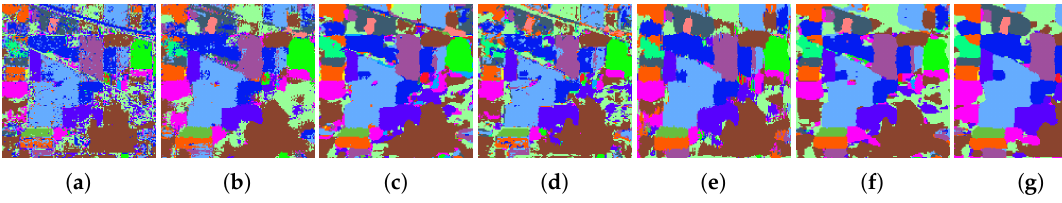
Figure 8. The classification maps of Indiana: ( a ) P-SVM-RBF, ( b ) P-CNN, ( c ) CRNN, ( d ) 3-D-CNN, ( e ) 3-D-CNN-LSTM, ( f ) L-CLSTM, and ( g )